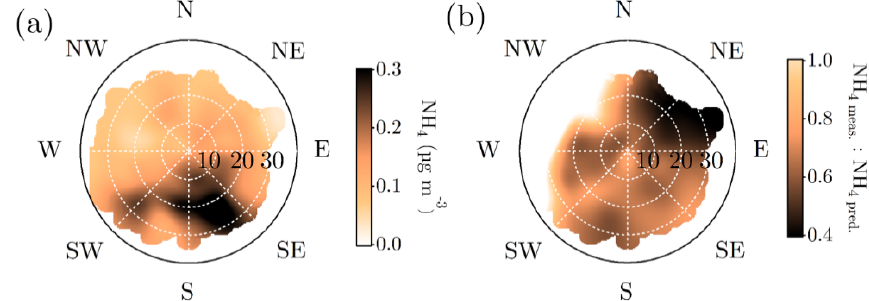
Figure 10. Openair polar plots for ammonium (a) and the ratio between measured and predicted ammonium (b) . The distances from the origin indicates wind speeds in kmh − 1 . The wind speed grid lines are presented with dashed white circles. The color scales represent the concentration (a) and the unitless ammonium ion balance ratio (b) observed with each wind speed and direction combination. As the figures do not indicate any likelihood of the wind speed and distance combinations, Fig. A1 is important to keep in mind while interpreting them. Briefly, N–NE–E is the least probable wind direction, whereas S–SW–W is the most likely. Wind speeds generally stay below 20kmh − 1